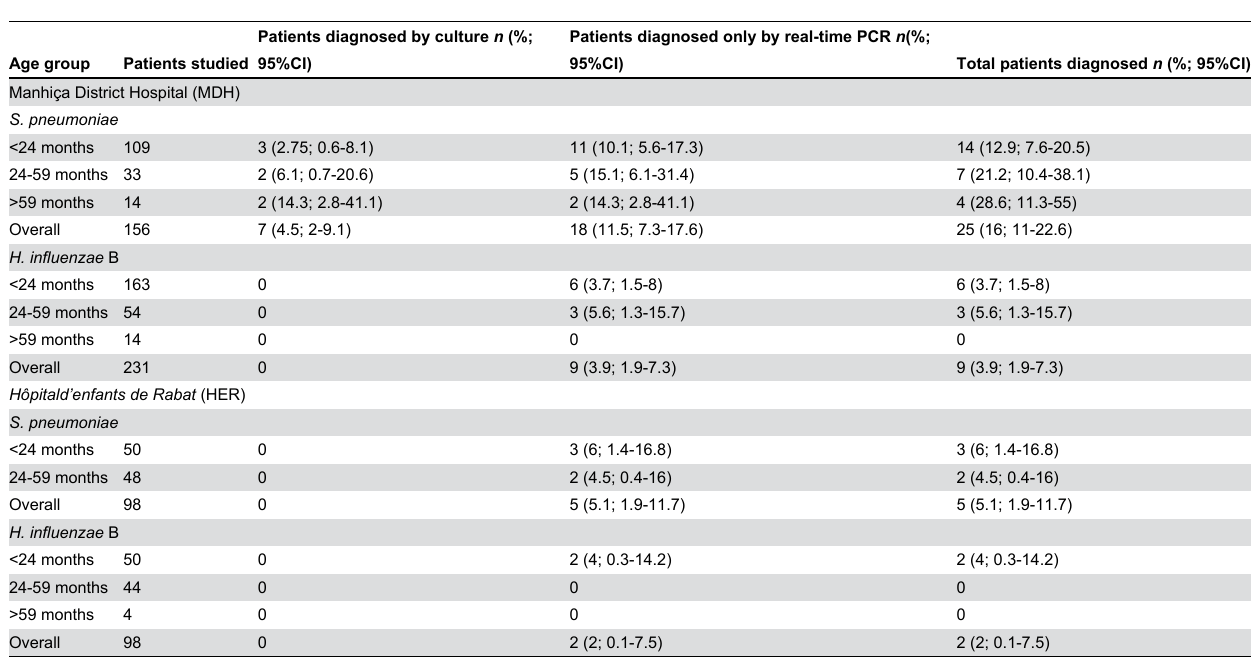
Table 3. Microbiological diagnosis of patients according to age group and geographical site.